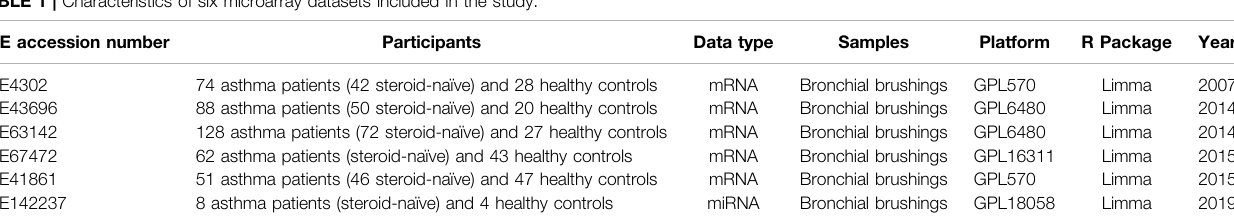
TABLE 1 | Characteristics of six microarray datasets included in the